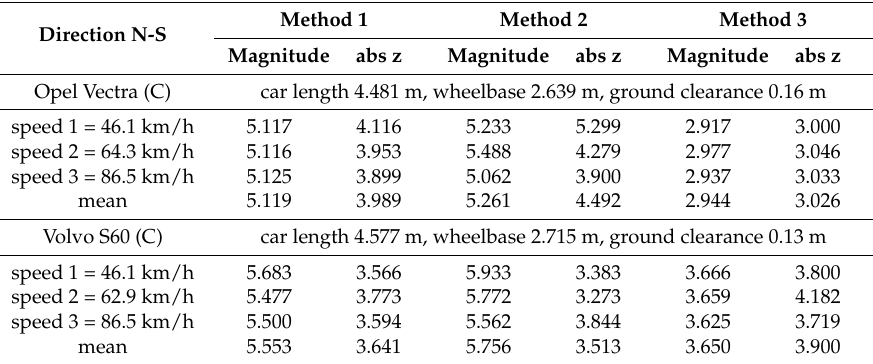
Table 1. Signature length and two-extreme-peak distances (in meters) computed by means of three methods, abs z—absolute z.